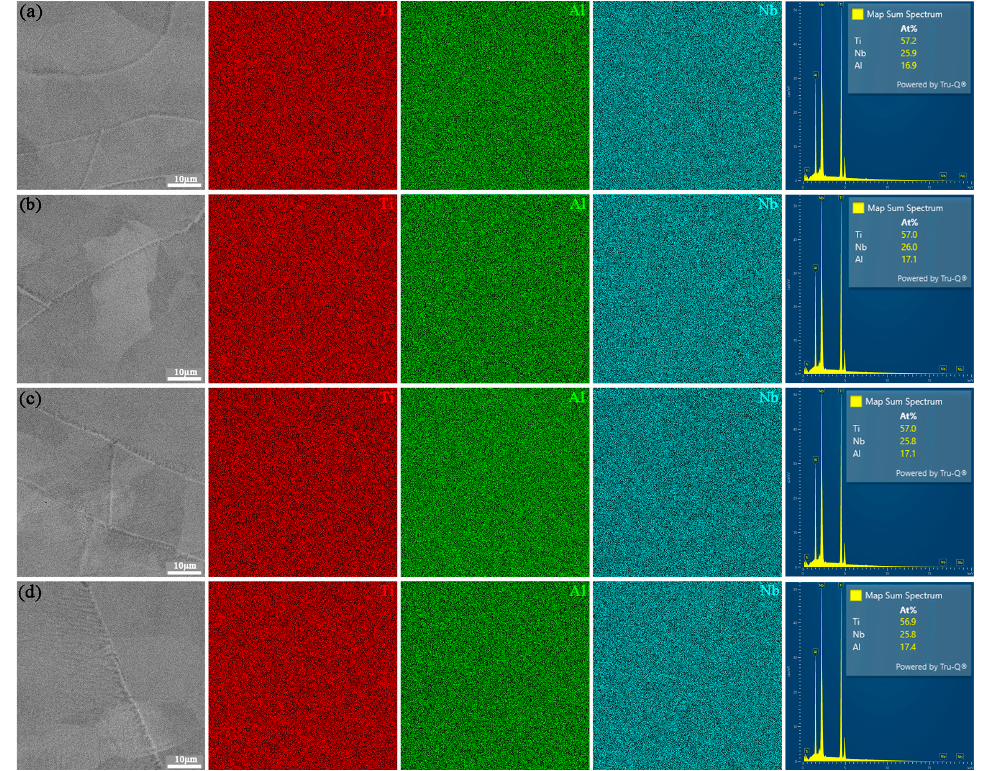
Figure 5. SEM images and their corresponding EDX composition maps of the Ti-22Al-25Nb samples: ( a ) sample 1, ( b ) sample 2, ( c ) sample 3, and ( d ) sample 4.